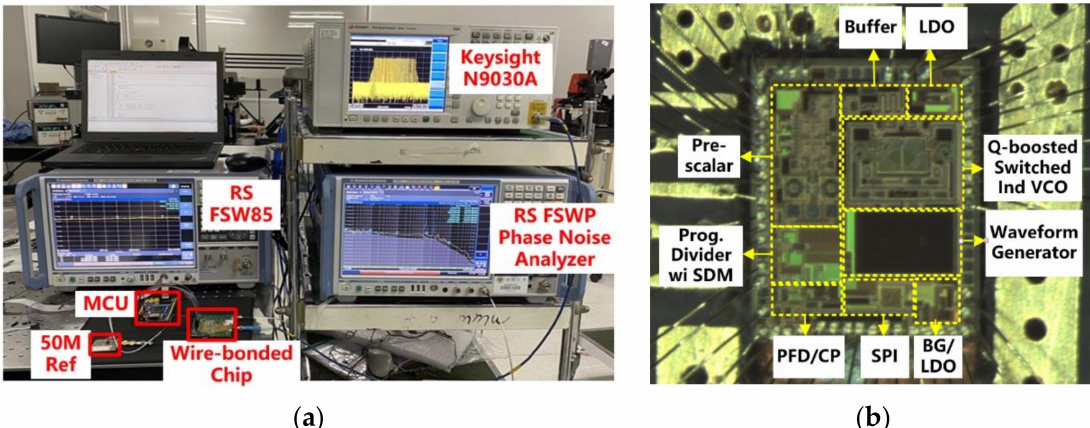
Figure 5. ( a ) Measurement setup environment for the f 0 output spectrum (with Keysight N9030A), chirp signal analyzing (with R&S FSW85), and phase noise (with R&S FSWP Phase Noise Analyzer) of the K-band FMCW source chip; ( b ) photograph of the wire-bonded K-band FMCW source